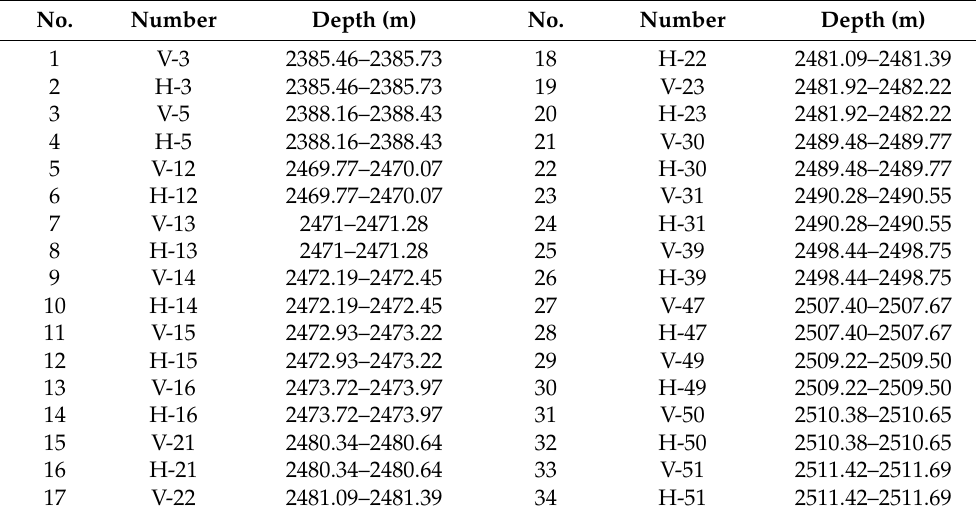
Table 1. Information on shale gas well rock samples.